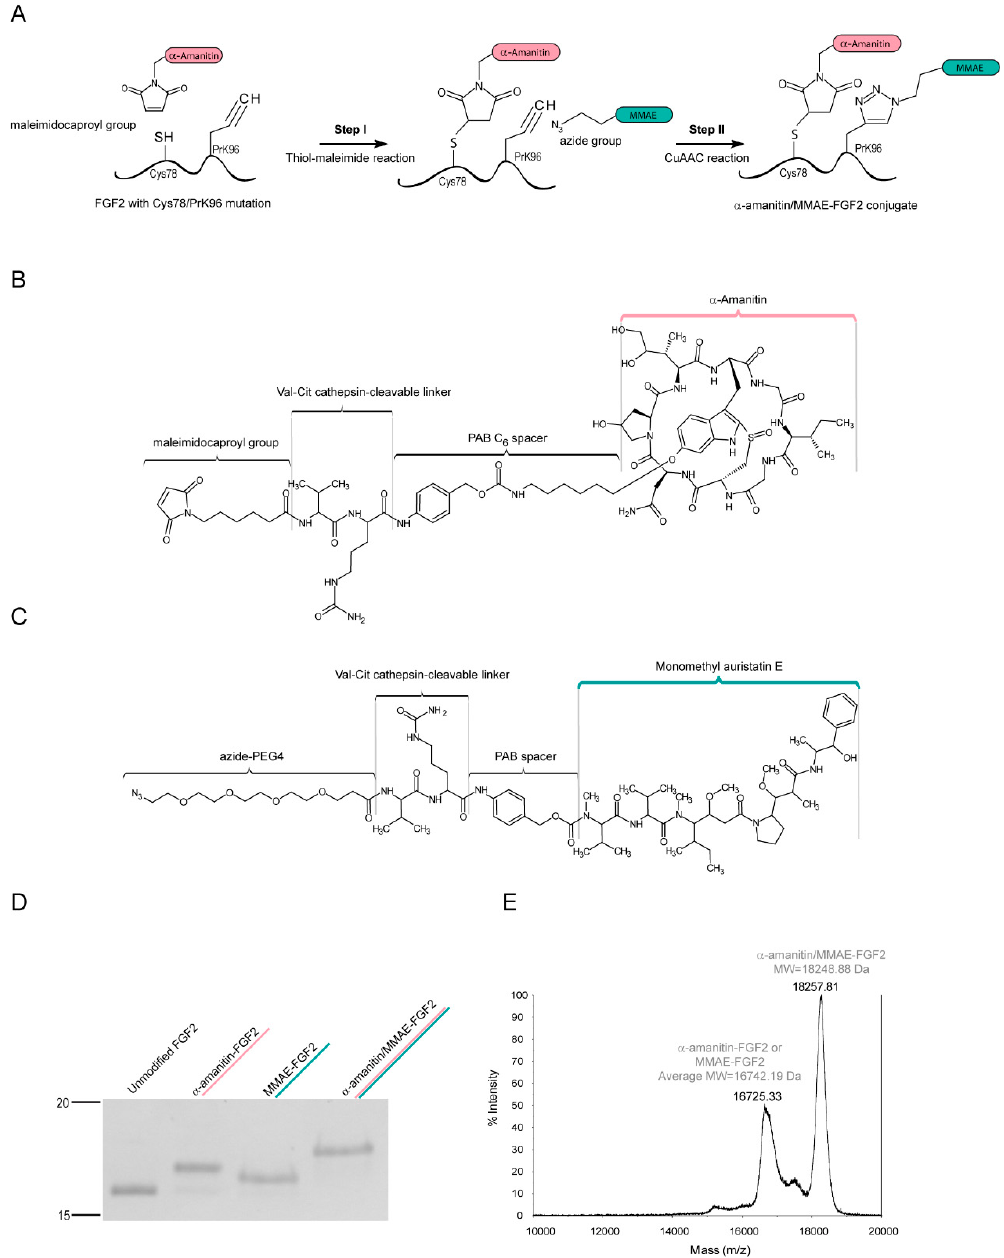
Figure 1. Site-specific conjugation of fibroblast growth factor 2 (FGF2) to α -amanitin and monomethyl auristatin E (MMAE). ( A ) Schematic representation of a site-specific dual conjugation by thiol-maleimide and Cu(I)-catalyzed alkyne-azide cycloaddition (CuAAC) reactions; ( B ) Chemical structure of maleimidocaproyl-Val-Cit-PAB- α -amanitin and ( C ) azide-PEG4-Val-Cit-PAB-monomethyl auristatin E; ( D ) SDS-PAGE analysis confirmed the purity of obtained conjugates; ( E ) Mass spectrometry (MS) analysis of doubly conjugated FGF2 shows attachment of one α -amanitin and one MMAE compound per one protein molecule.